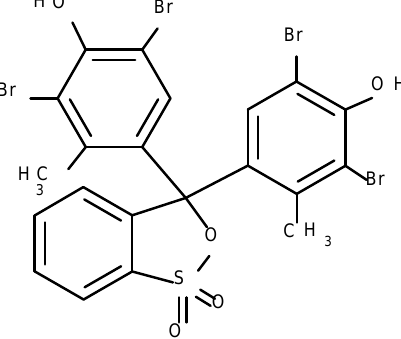
Figure 1. Structure of Bromocresol green.